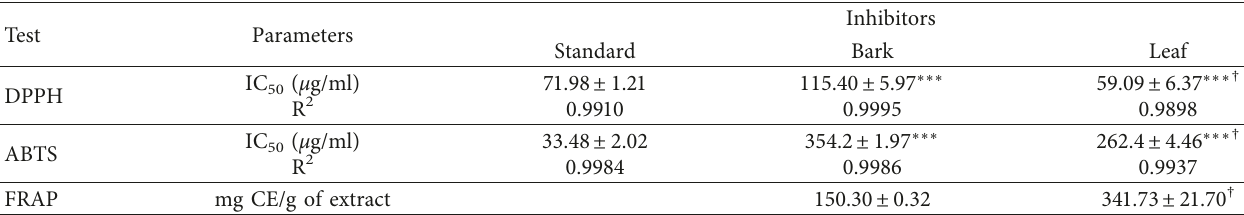
Table 2: IC 50 and correlation coefficient ( r ) of the hydro-ethanolic leaf and bark extracts in DPPH, ABTS assay, and the ferric reducing power activity in the FRAP assay.